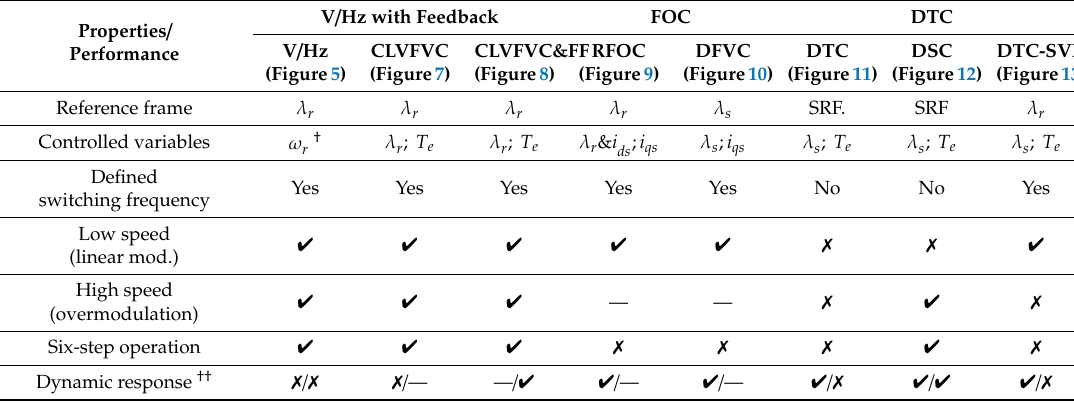
Table 1. Summary of the presented control schemes for traction